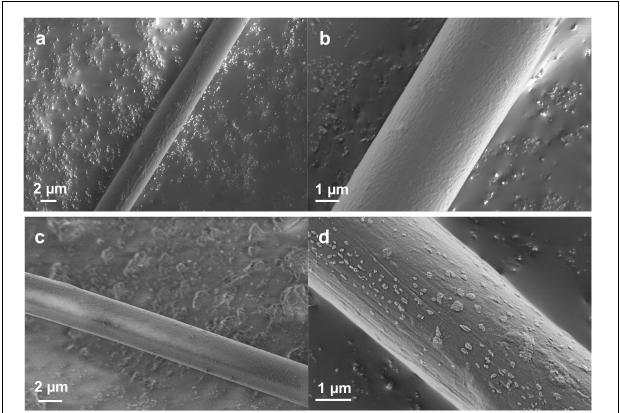
FIGURE 1 | FE-SEM images showing the surface of silk fibers at different magnifications. (a,b) Native Nephila spider dragline. (c,d) Nephila spider dragline after ether